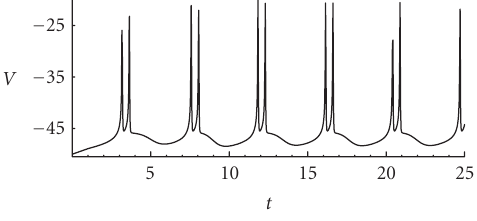
Figure 2.10. Time sequence of membrane potentials for g K , C = 15 . 2 s − 1 .